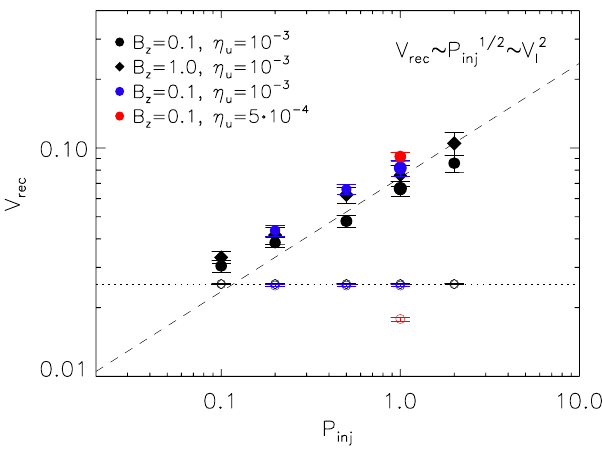
Fig. 9. The dependence of the reconnection speed V rec on the uni- form viscosity coefficient ν . As explained in the text, the reconnec- tion speed is reduced with increasing value of ν . The dotted line corresponds to the Sweet-Parker reconnection rate. Error bars and the size of symbols have the same meaning as in Fig.